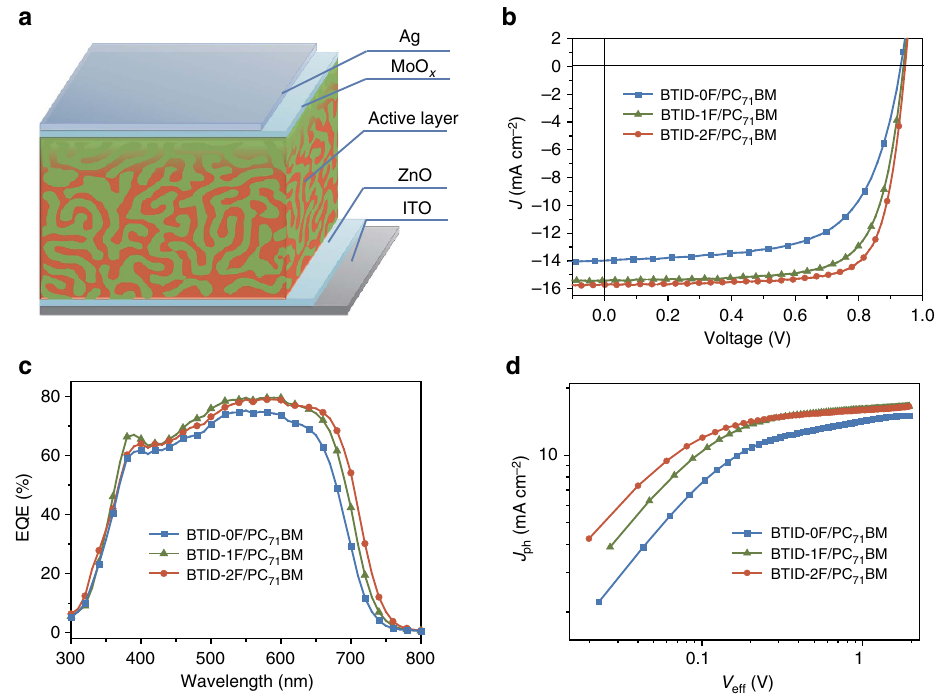
Figure 2 | Device structures and photovoltaic properties for inverted solar cells. ( a ) Structures of inverted device; ( b ) optimized J – V curves for inverted devices; ( c ) EQE corresponding to devices in b , d photocurrent density versus effective voltage ( J ph – V eff ) characteristics for devices under constant incident light intensity (AM 1.5G, 100mWcm (cid:2) 2 ).